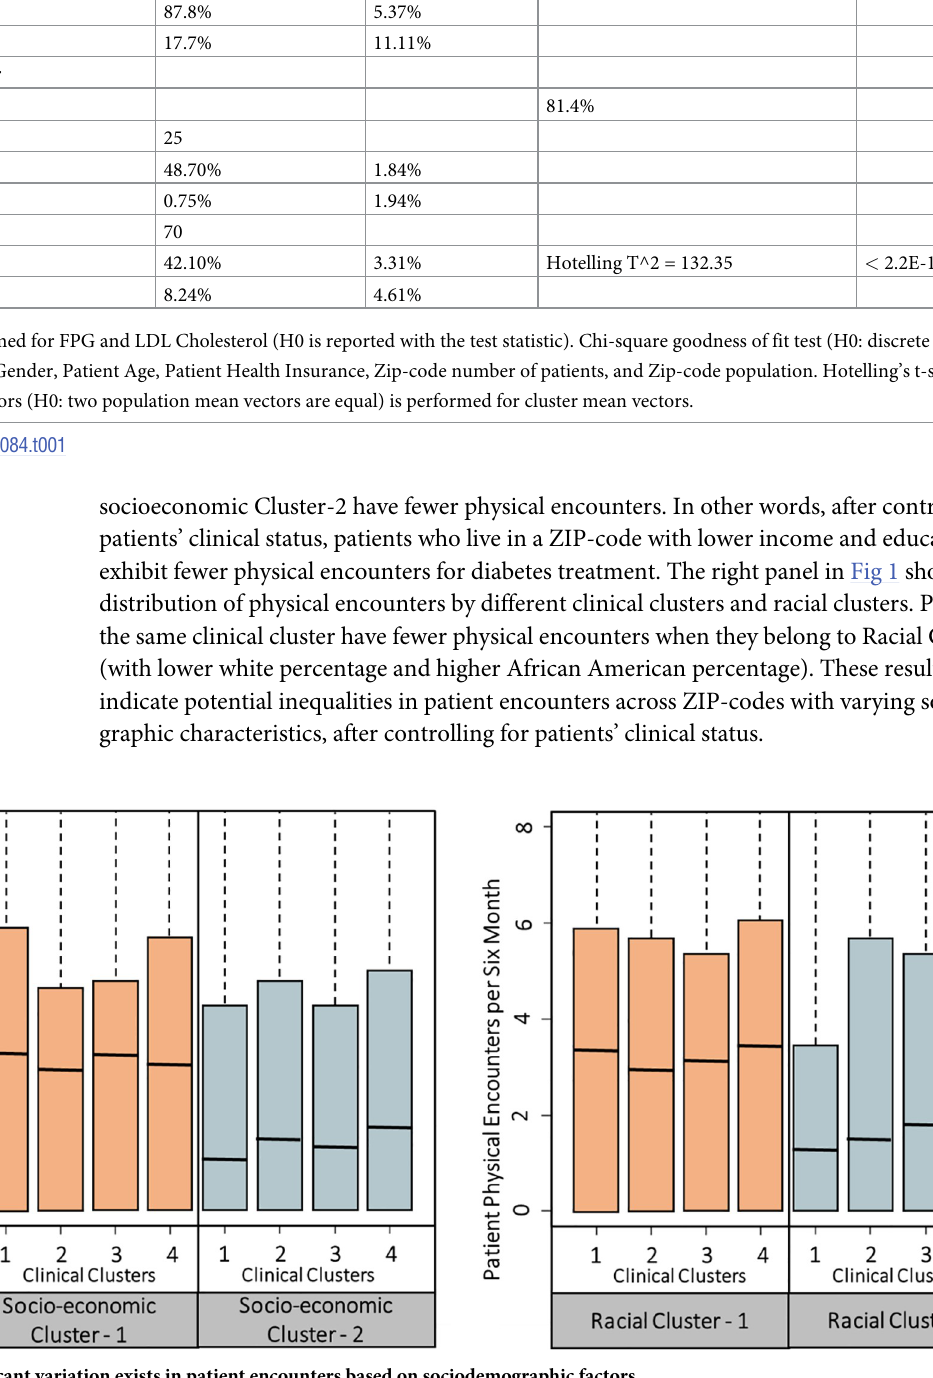
Fig 1. Significant variation exists in patient encounters based on sociodemographic